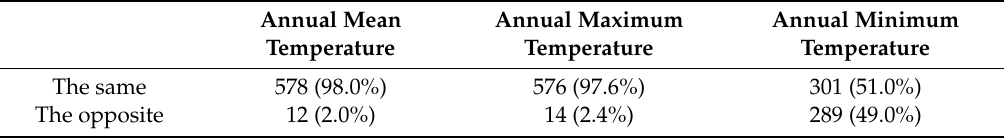
Table 3. The number and percentage (in bracket) of the sites where the observed and gridded annual data are with the same climate trends (OGSP index) and opposite climate trends in mainland China.